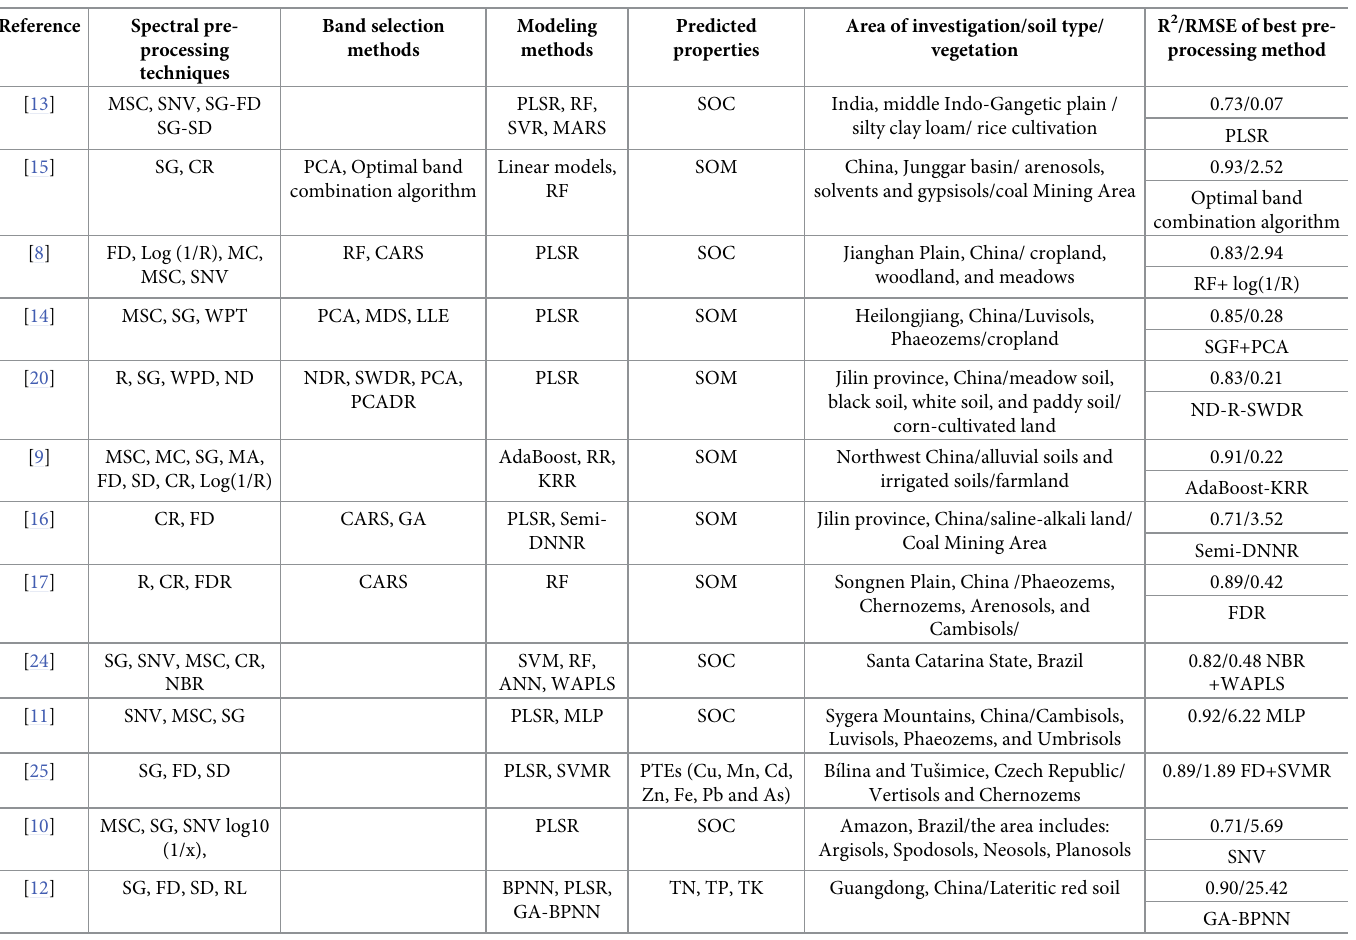
Table 1. Summary of spectral band selection and modeling techniques for soil properties